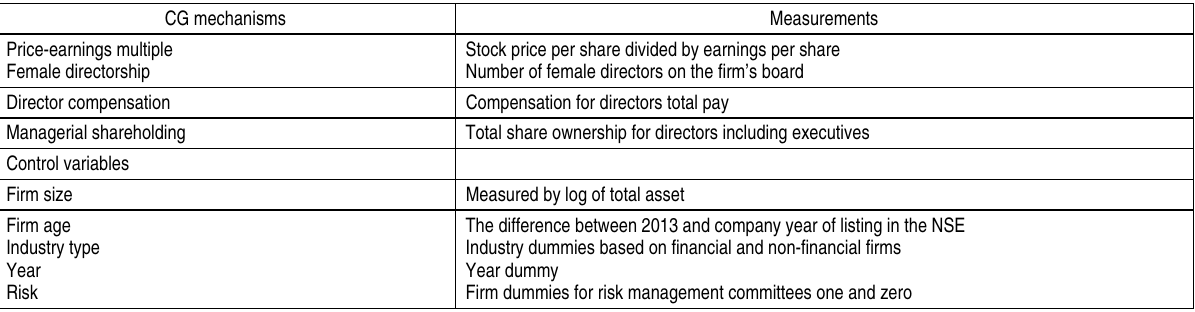
Table 1. Variable definition and